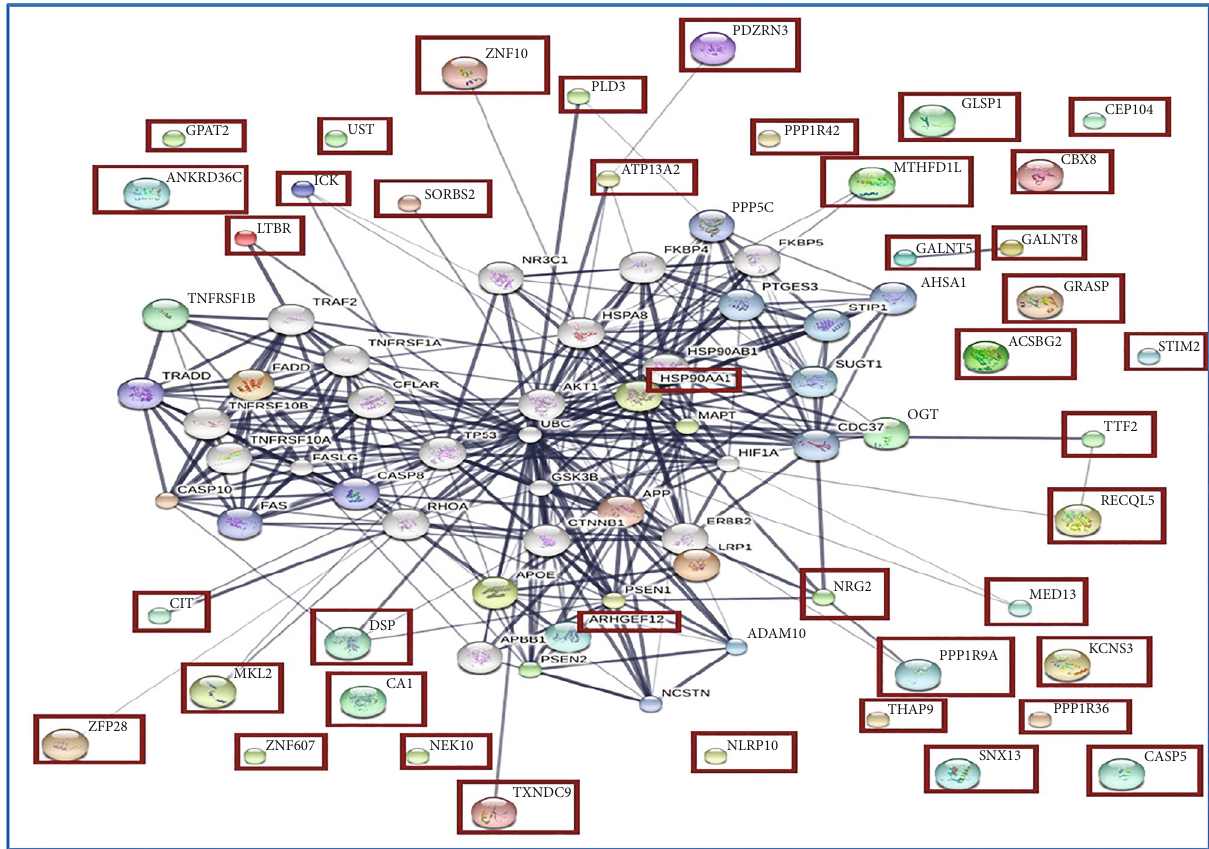
Figure 2: Protein-protein interaction identi fi ed from serum of the AD group. Stronger associations are represented by thicker lines. Protein- protein interactions are shown in grey, chemical-protein interactions in green, and interactions between chemicals in